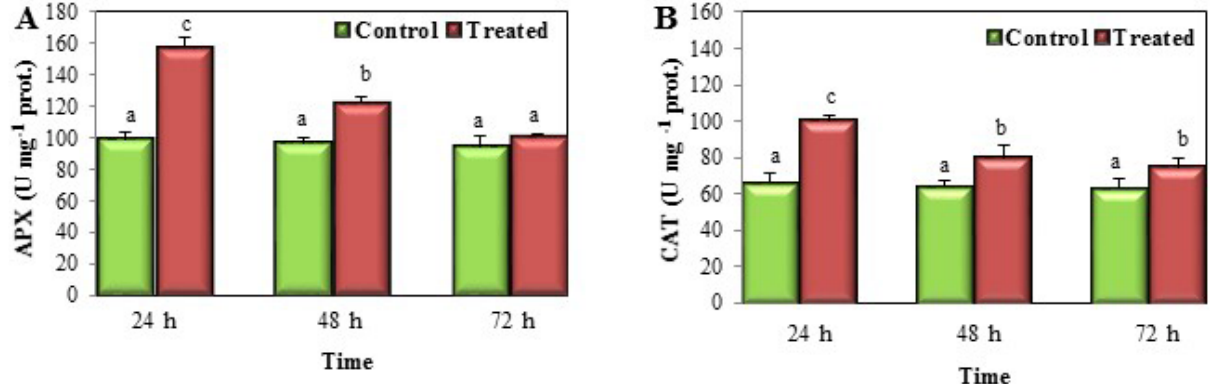
Figure 2. Specific activity of APX (A) and CAT (B) enzymes in leaf tissues of treated and untreated Chenopdium album plants at 24 h intervals. Data are mean values ± SD of four experiments. Bars with different letters were significantly different ( P <0.05) from each other. For APX, 1 U = 1 nmol of ascorbate oxidized min −1 ; for CAT, 1 U = 1 nmol of H 2 O 2 dismutated min −1 .